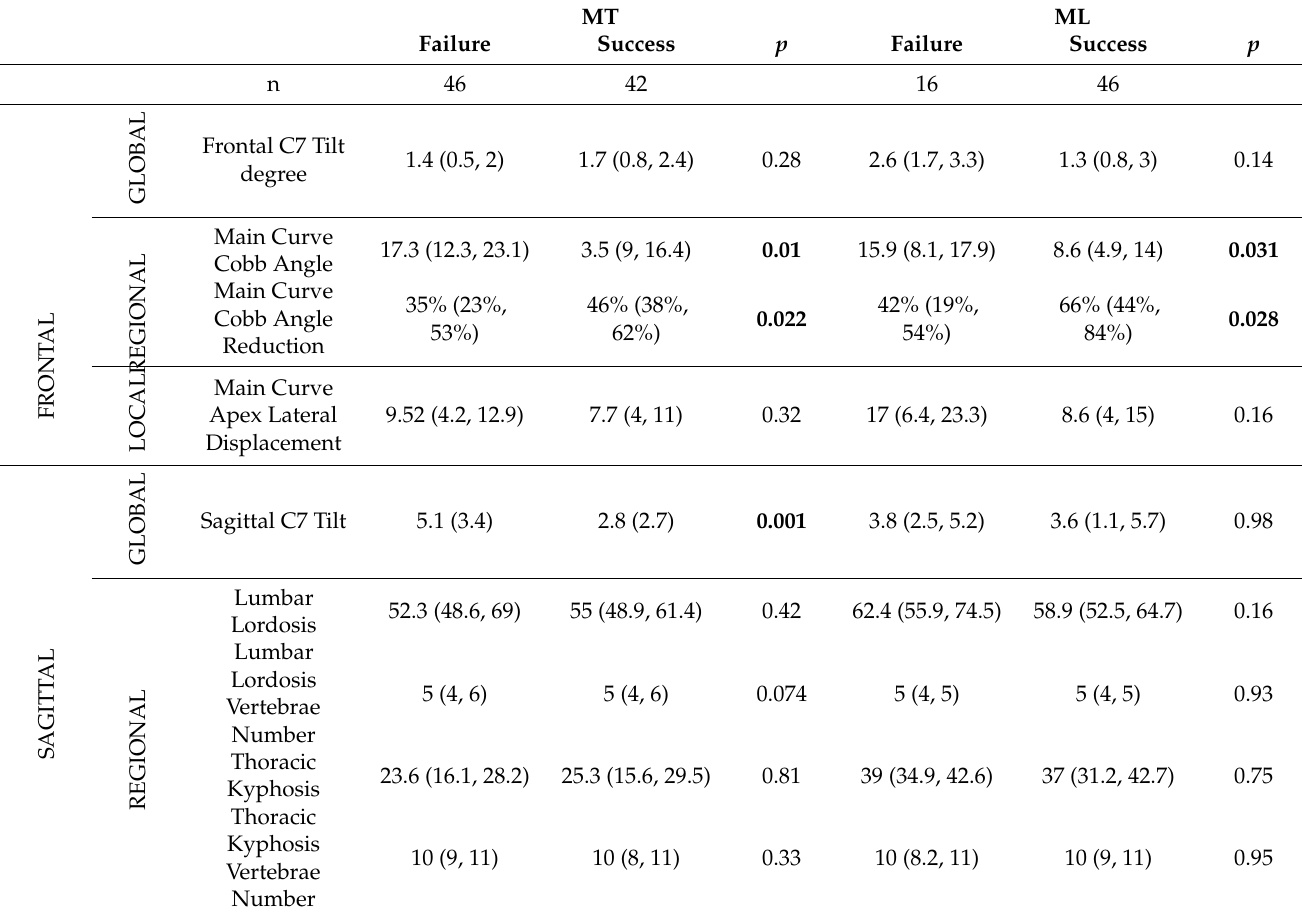
Table 5. Inbrace EOS Roentgenogram measures date 2 (median (IQR)). Bold indicates p < 0.05